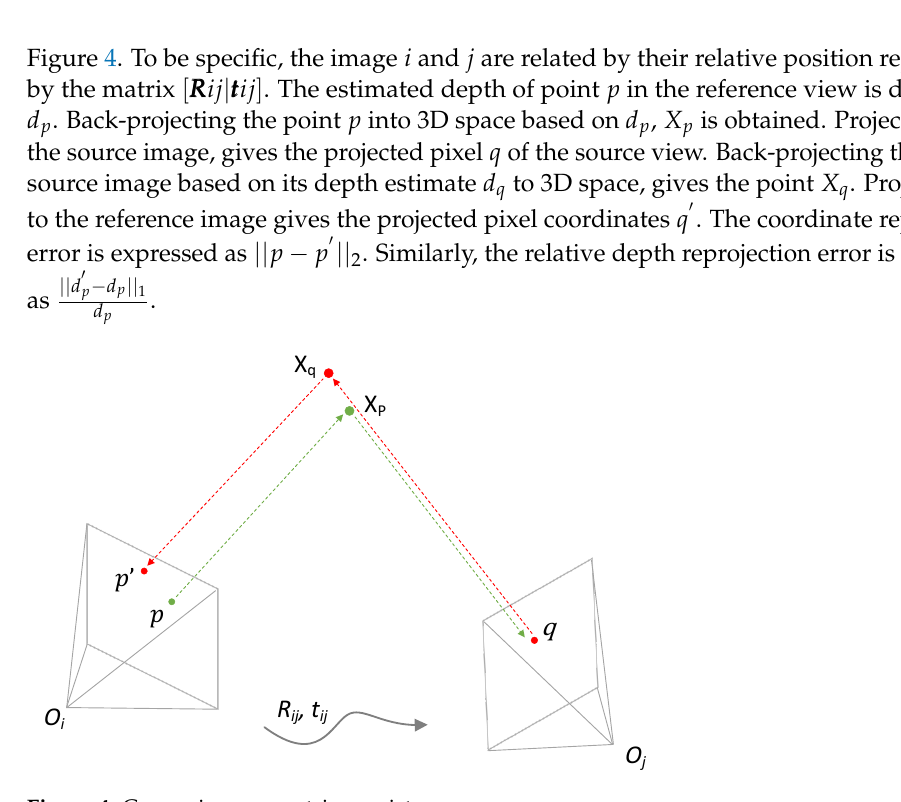
Figure 4. Cross-view geometric